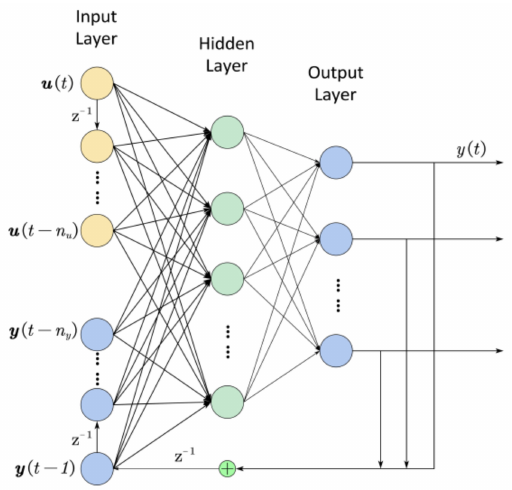
Figure 7. Diagram of the NARX model network